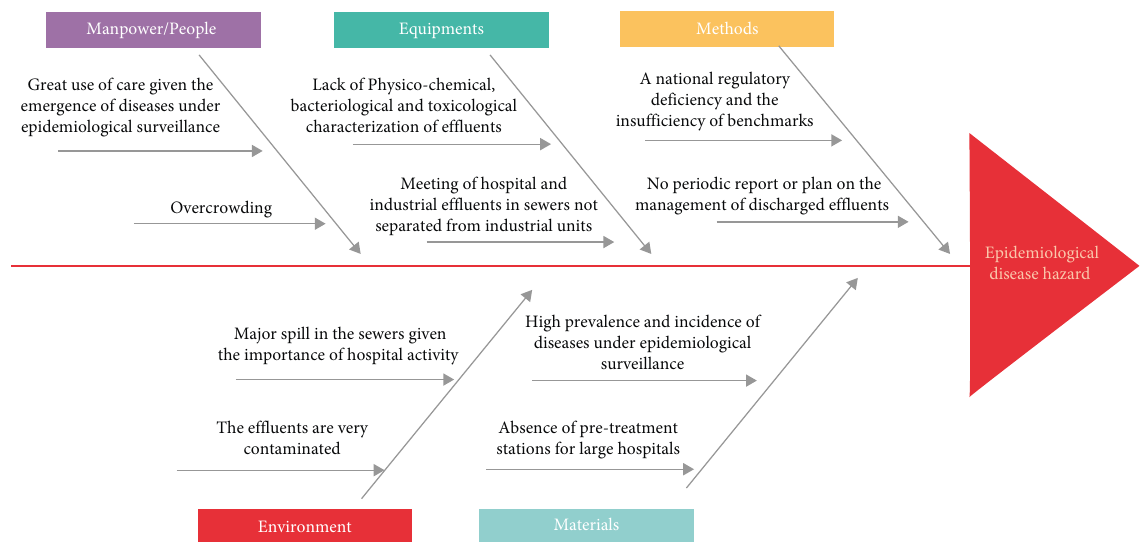
Figure 3: The inventory of the causes of the epidemiological disease hazard in the Casa-Settat Table 1: Distribution of diseases under epidemiological surveillance according to Moroccan regions.